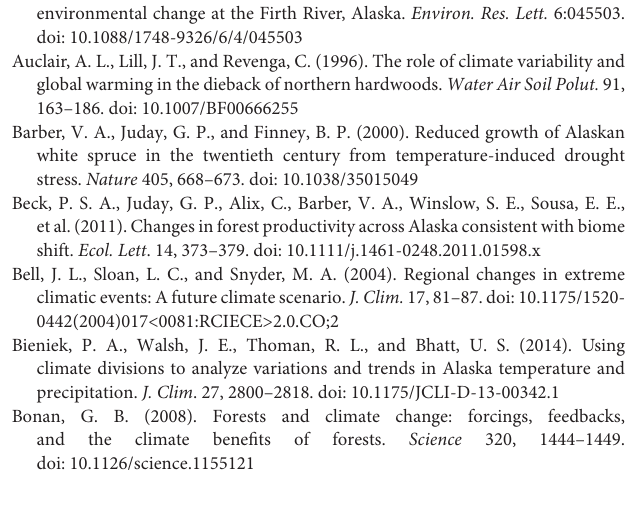
Supplementary Figure 1 | Mean tree-ring series (black line) and respective standard deviation (shaded area) for the six study